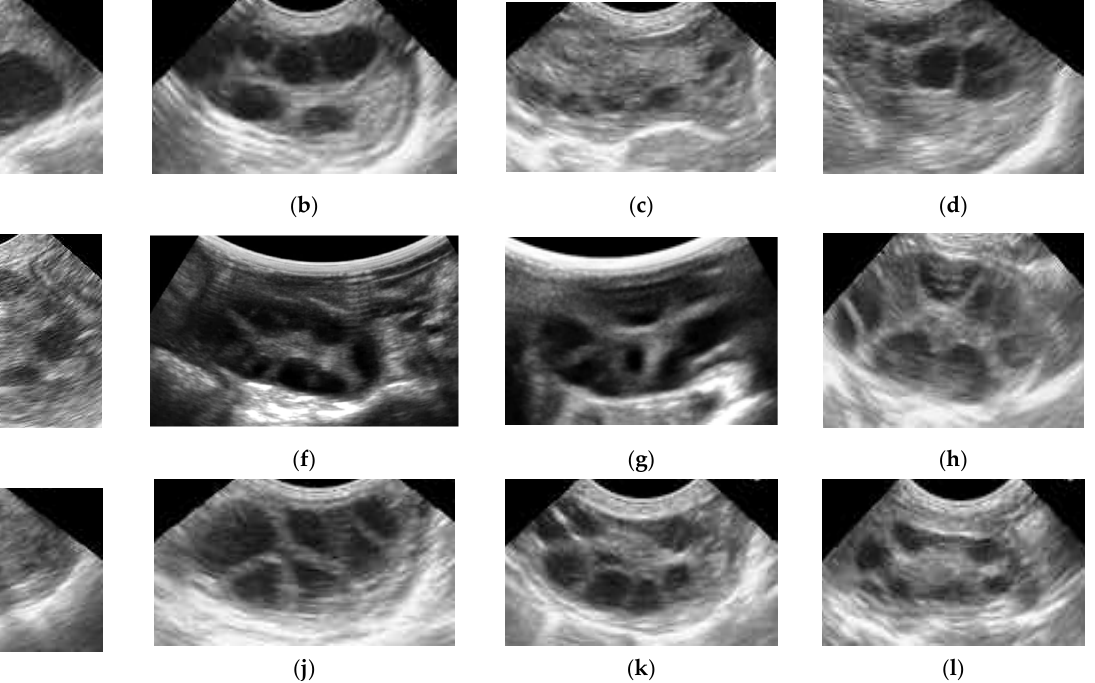
Figure 2. Ultrasound images representing the follicular growth during all three protocols. ( a ) Prot 1.